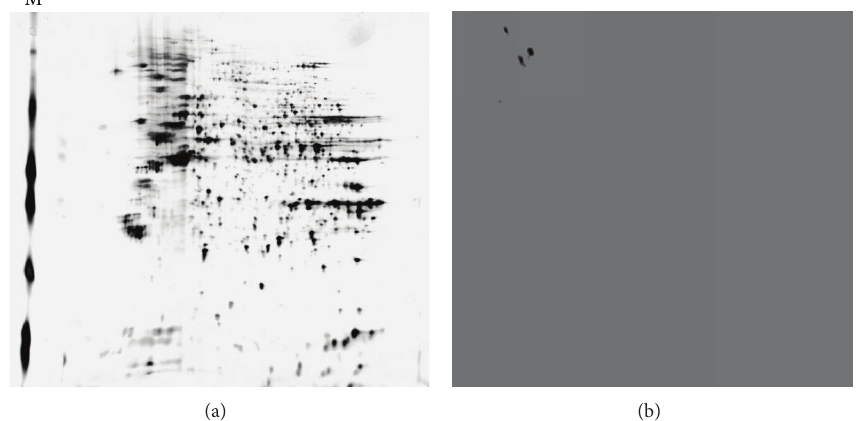
Figure 1: (a) 2-DE gel showing the proteome map of total soluble protein from BLZ211 cells. M: mw markers. (b) Western blot showing 3 spots.